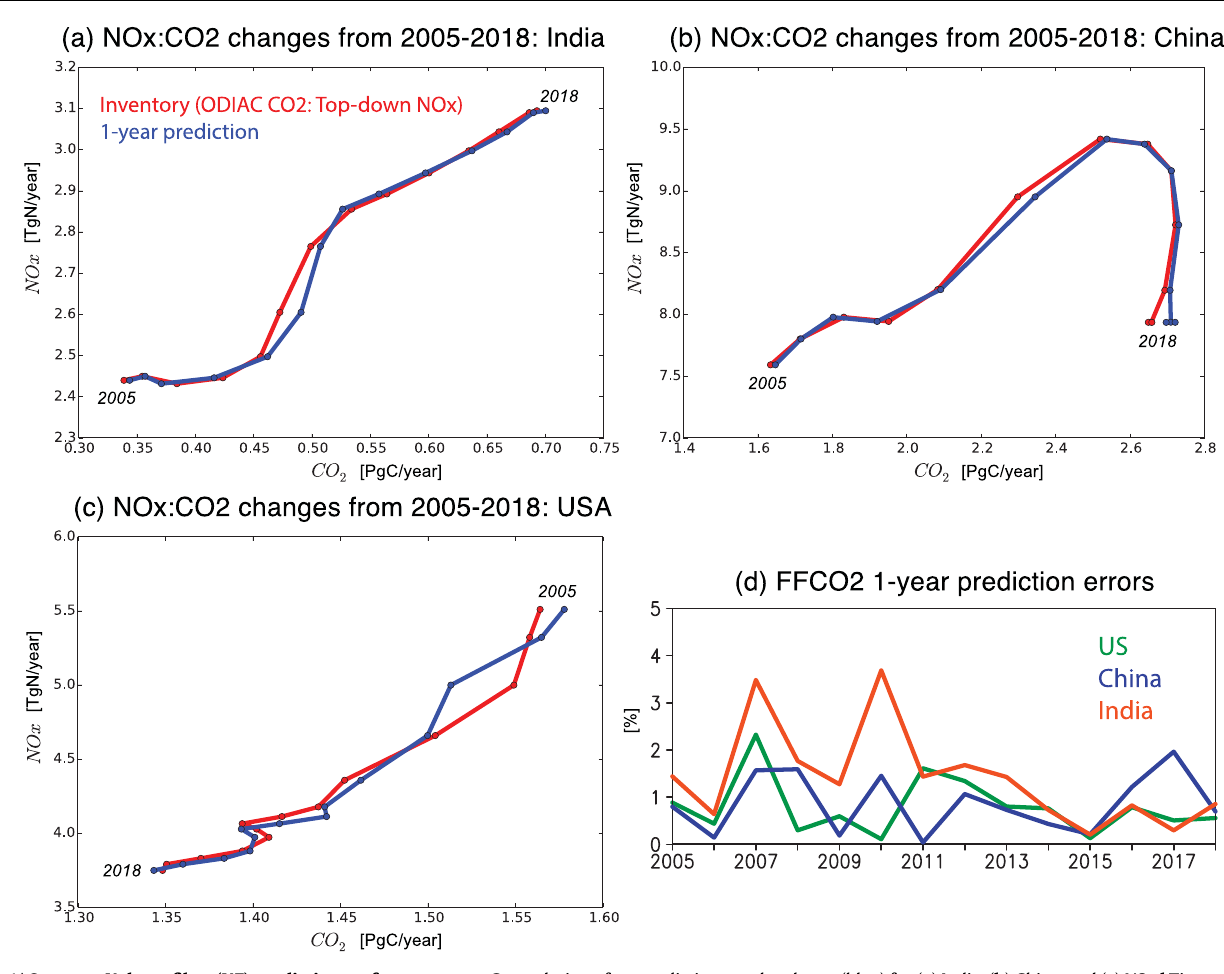
predictionarealsoshown(blue)for( a )India,( b )China,and( c )US. d Timeseriesof root-mean-square (RMS)errorsof the one-yearKFFFCO 2 predictions(in %) forUS, China, and